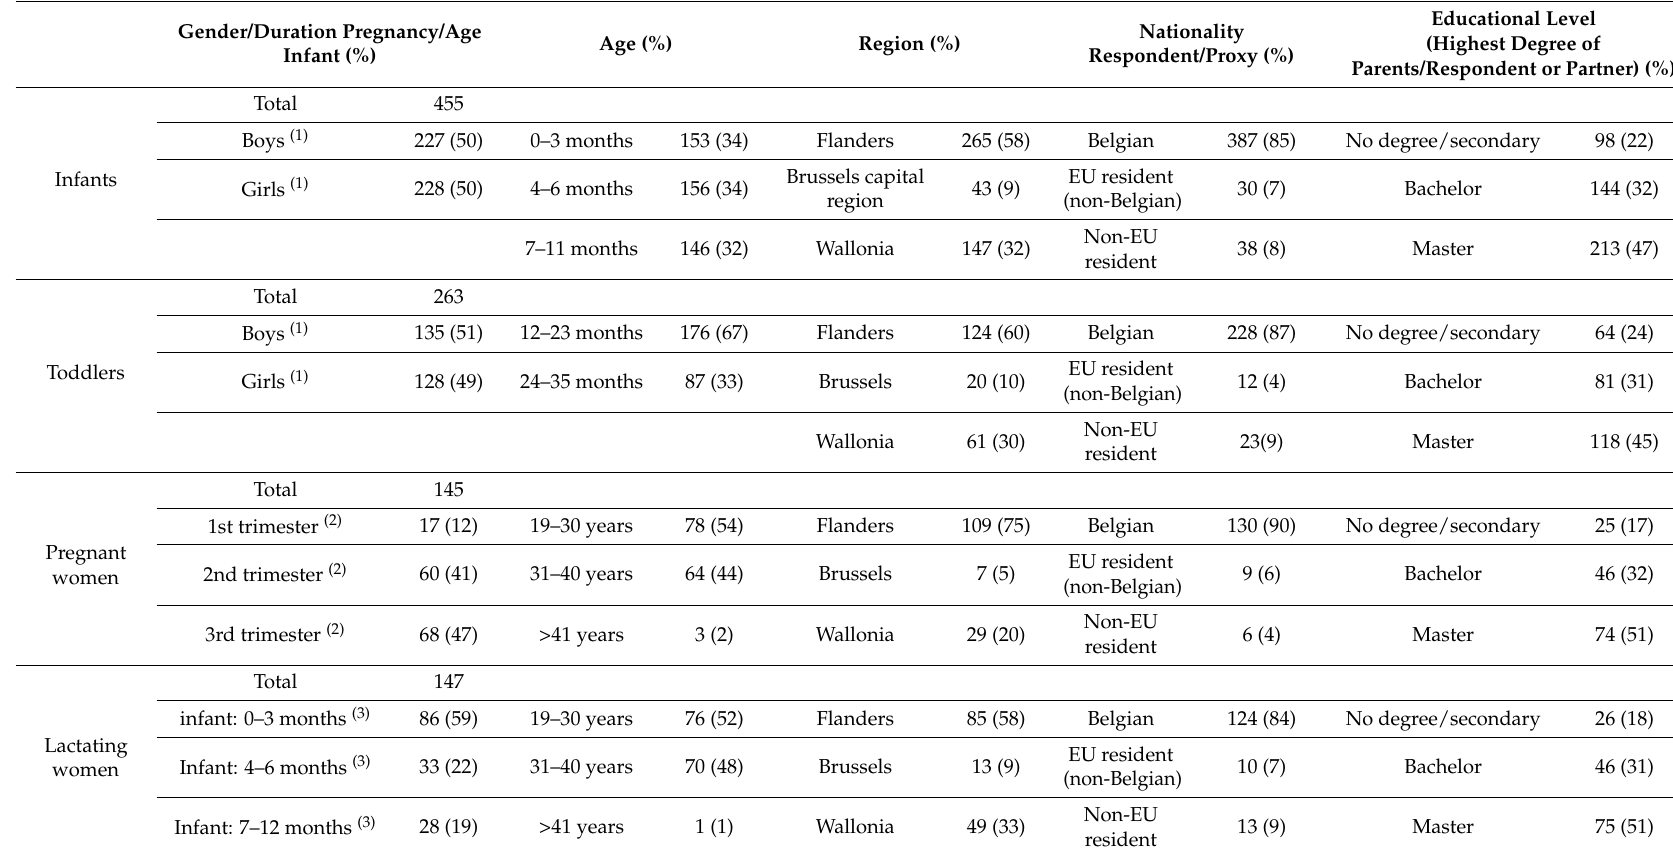
Table 1. Characteristics of the study population in a Belgian study of the intake of vitamins A, D, E, and K (VITADEK-study)